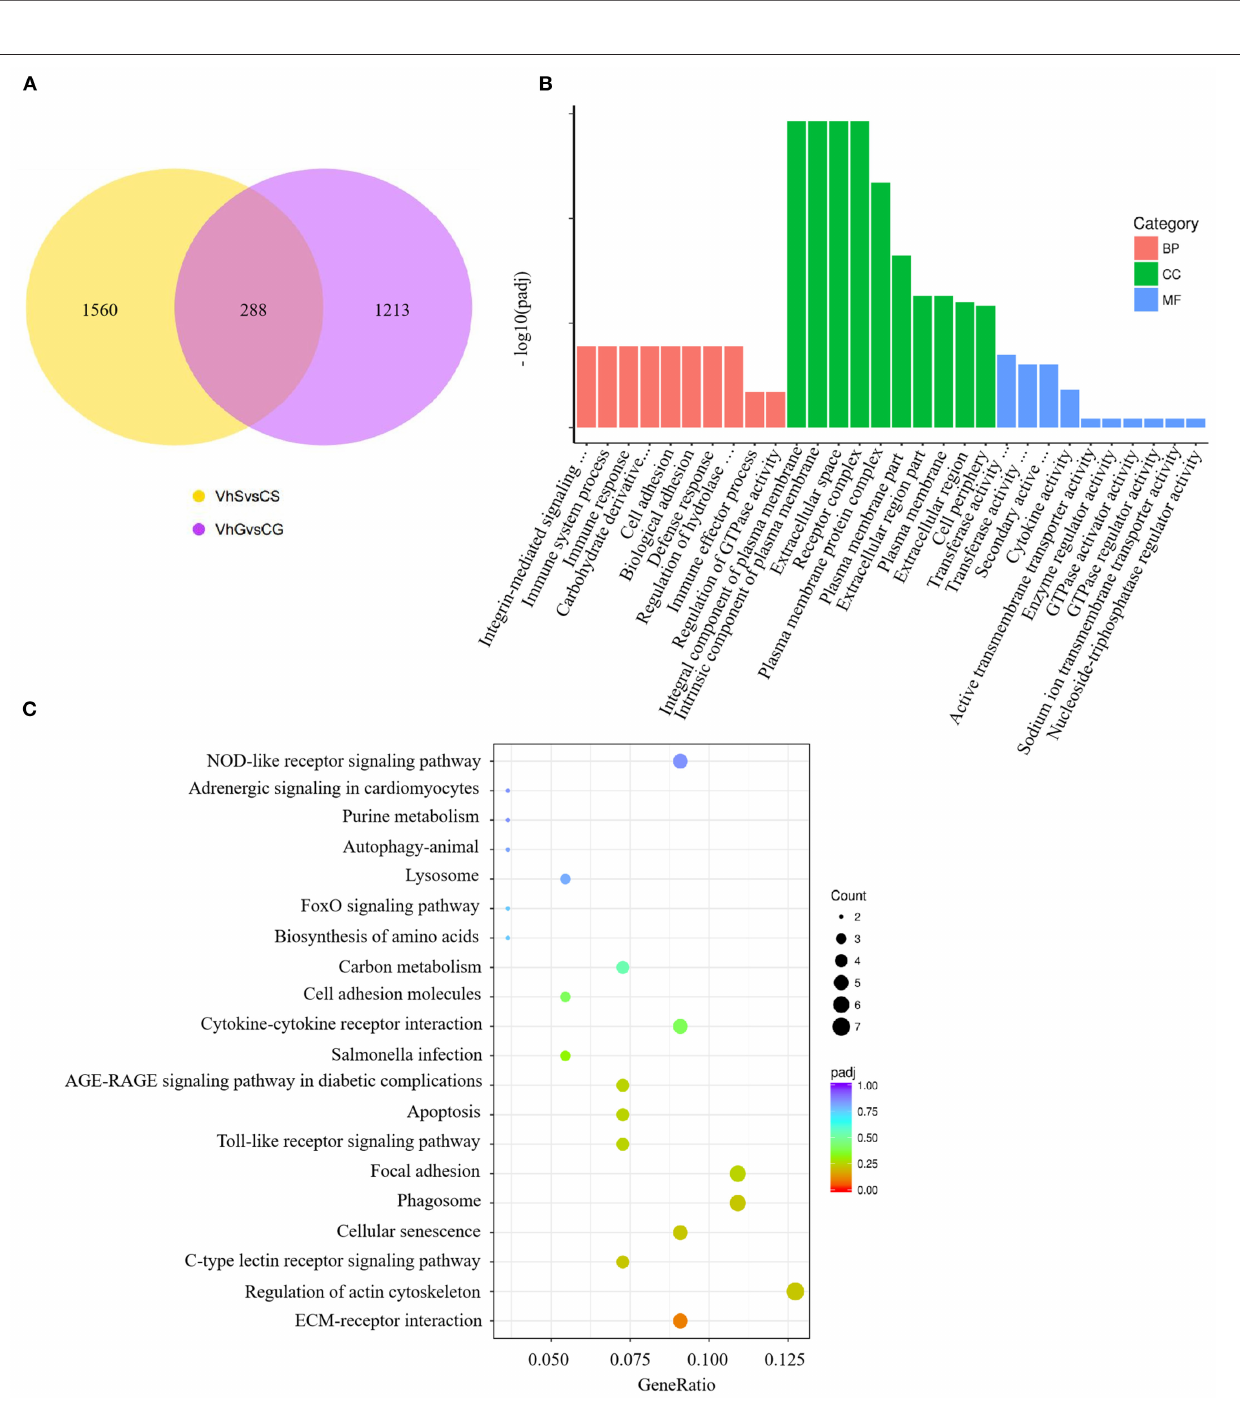
FIGURE 5 | Combined RNA-sequencing analysis of the spleen and gill. The overlapping DEGs in spleen and gill are shown in (A) . Top GO categories of overlapping DEGs are shown in (B) . The KEGG analysis of overlapping DEGs is shown in (C)